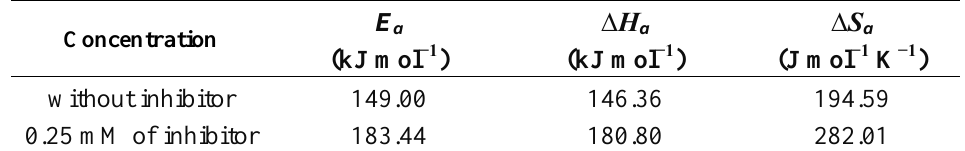
Table 5. Corrosion kinetic parameters for mild steel in 1.0 M H entropy of